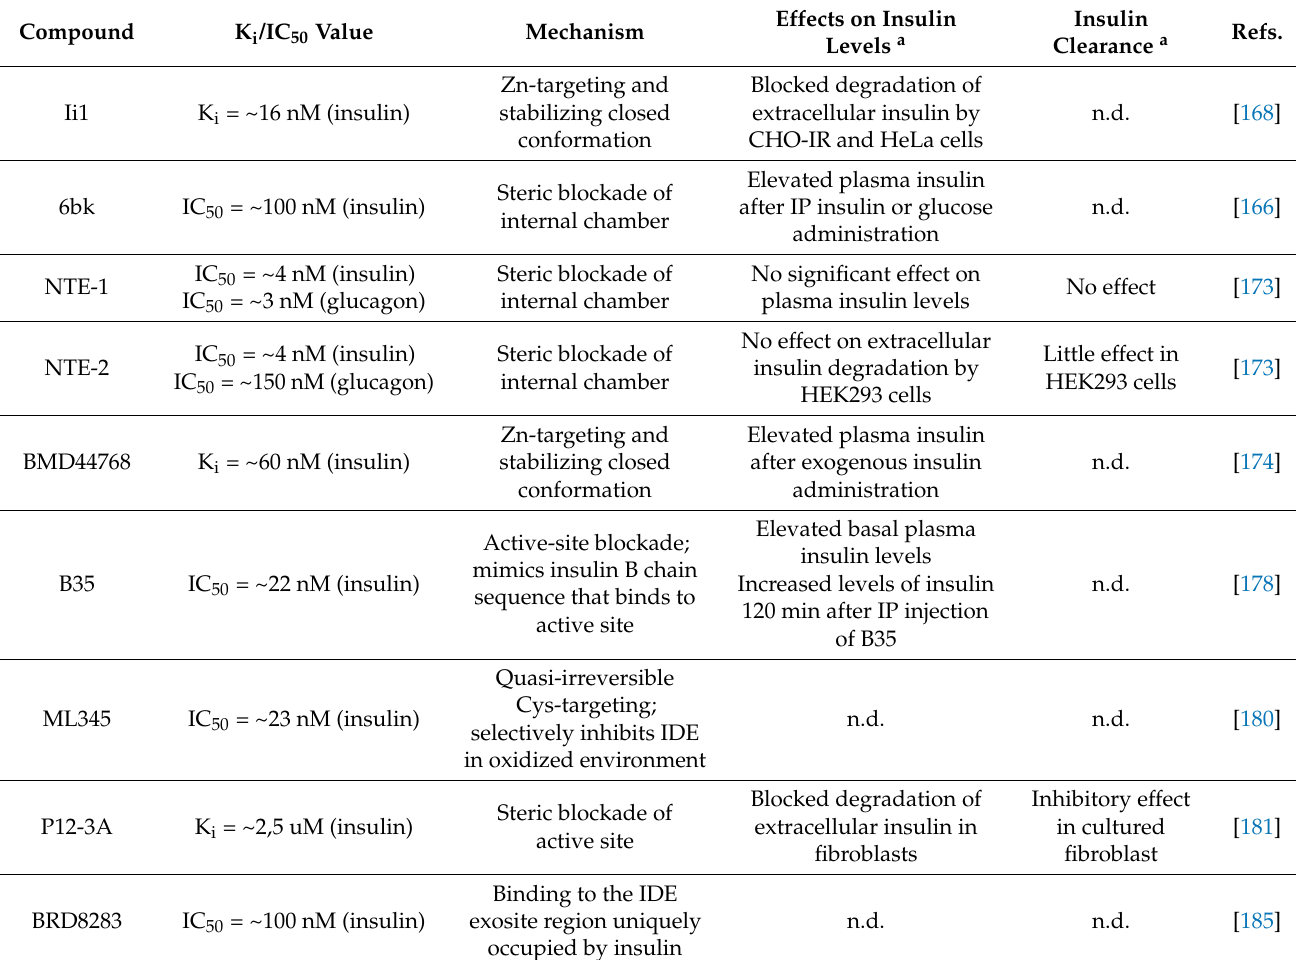
Table 1. Effects of IDE inhibitors on insulin clearance. n.d. = not determined. a From experiments in mice, unless otherwise